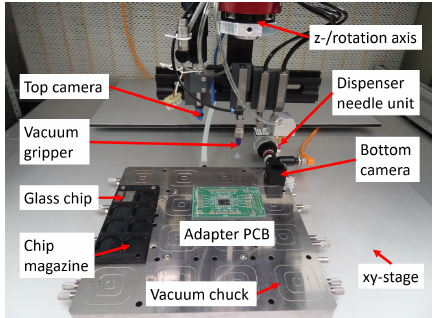
Figure 15. Handling platform MIMOSE equipped with ITO-coated glass chip and adapter PCB for the automated mounting